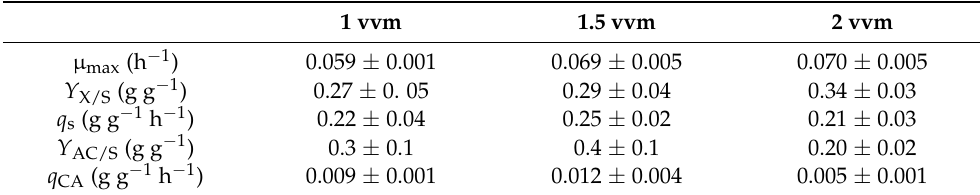
Table 2. Effect of aeration rate on maximum specific growth rate ( µ max ), biomass yield ( Y X/S ), specific consumption rate ( q S ), citric acid yield ( Y CA/S ), and maximum specific citric acid productivity ( q CA ) during bath culture of Y. lipolytica W29 in an airlift bioreactor. Data are presented as the average and standard deviation of two independent